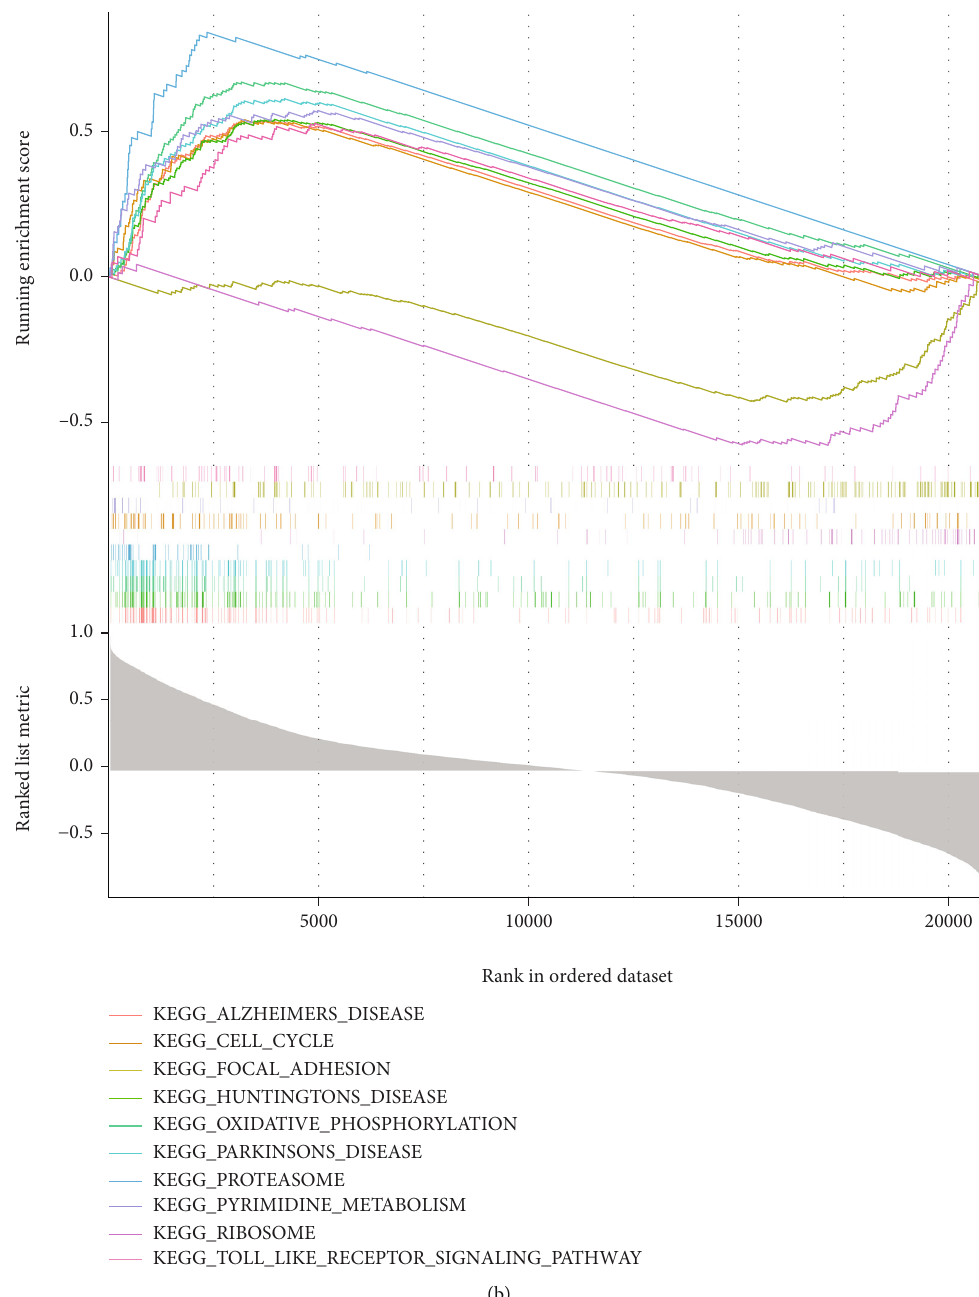
Figure 7: Single-gene GSEA of GJB2. (a) The top 10 enriched GO terms. (b) The top 10 enriched KEGG Table 2: The inhibitory drugs of GJB2. Gene Drug Interaction types